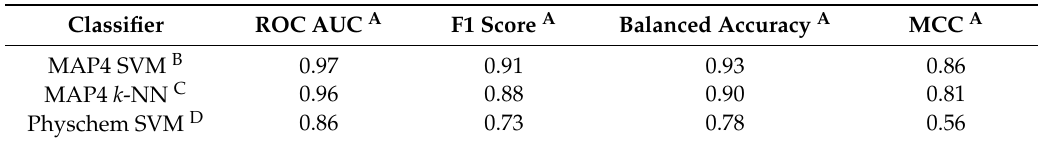
Table 3. SVM and k -NN classifier’s performance on the test set.